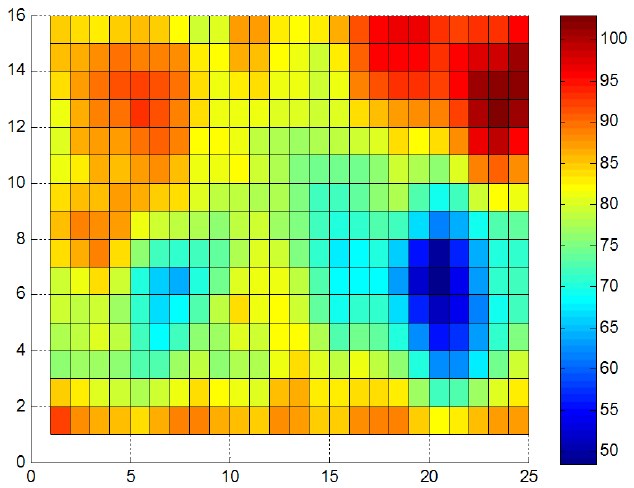
Figure 13. Matching result after adding motion